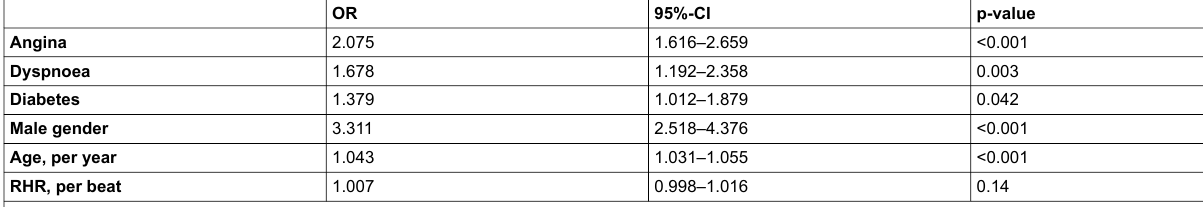
Table 4: Independent clinical predictors of CAD findings at